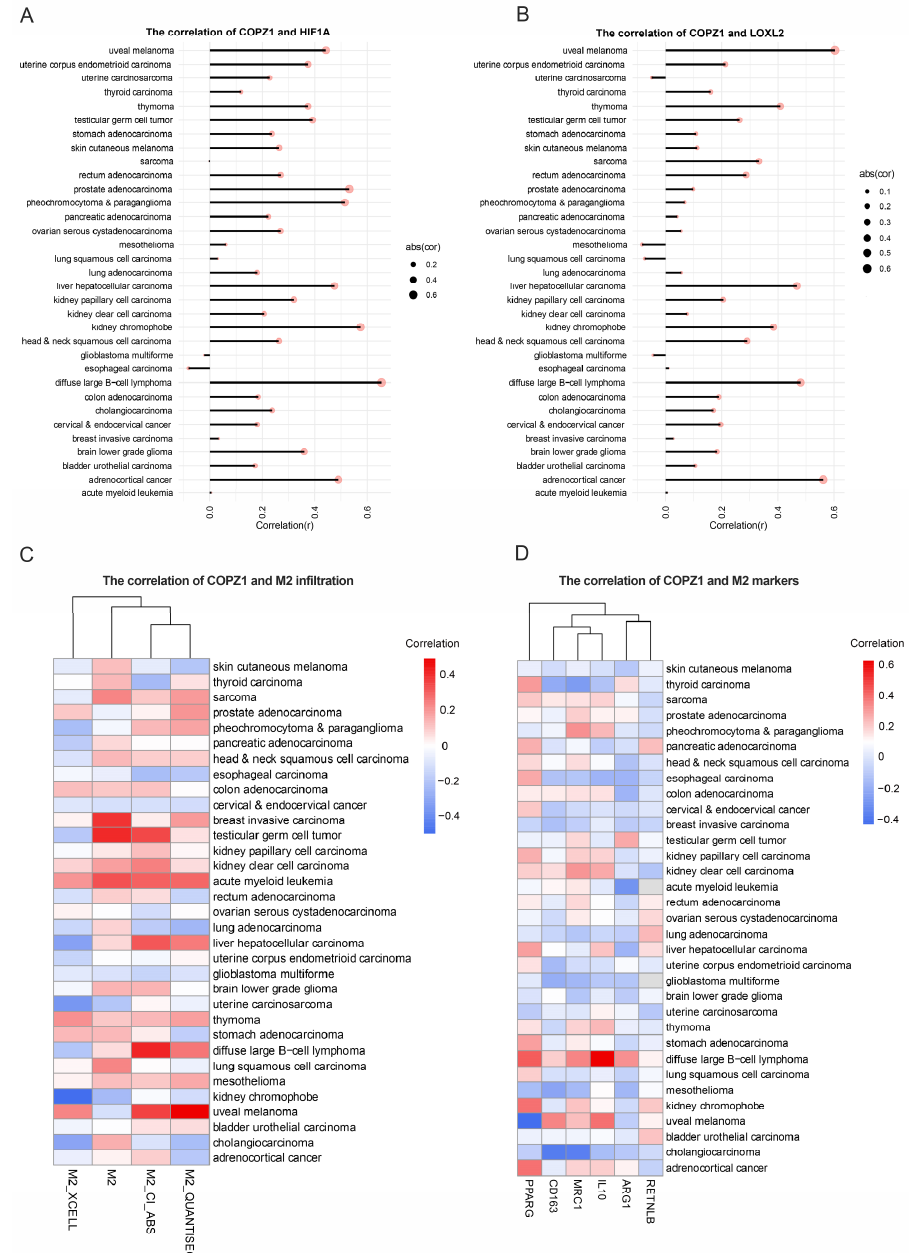
Figure 9. Correlation analysis between COPZ1 expression, hypoxia level and M2 infiltrating level. ( A ) The spearman analysis of COPZ1 expression and HIF1A expression in 33 types of cancer. ( B ) The spearman analysis of COPZ1 expression and LOXL2 expression in 33 types of cancer. ( C ) Heatmap showed the correlation of ZOPC1 expression and the M2 infiltration score generated by XCELL, CIBERSORT, CIBERSORT-ABS and QUANTISEQ in different cancer types. ( D ) Heatmap showed the correlation of ZOPC1 expression and the M2 marker expression.